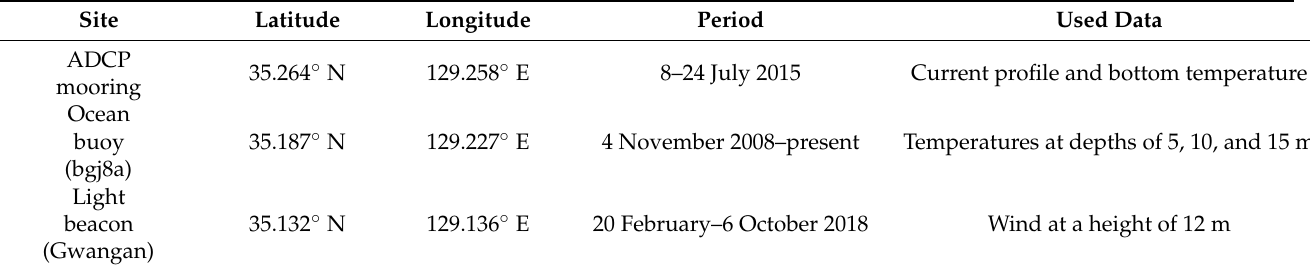
Table 1. Information regarding observations used in this study.